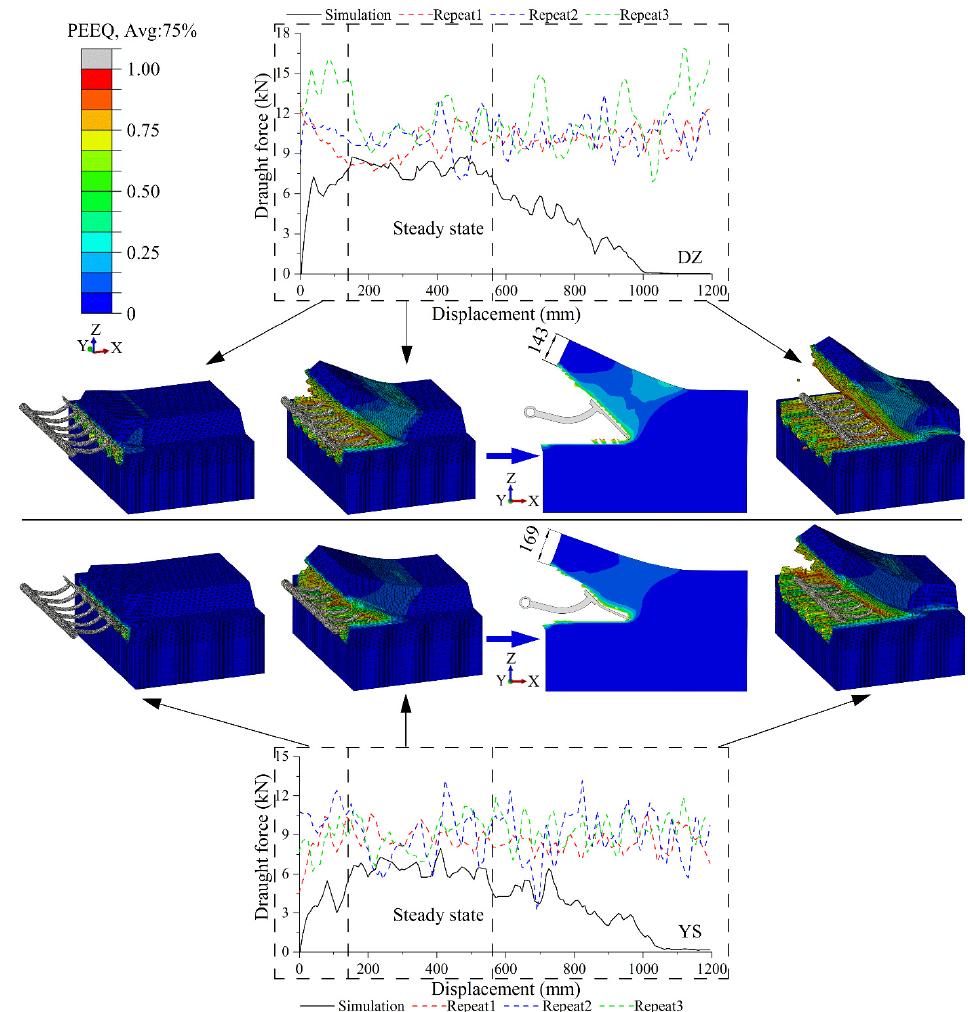
Figure 15. The simulated and field measured draught force and the simulated equivalent plastic strain of DZ (top) and YS (bottom). The solid lines represent the simulated values and dash lines represent the field measured values.